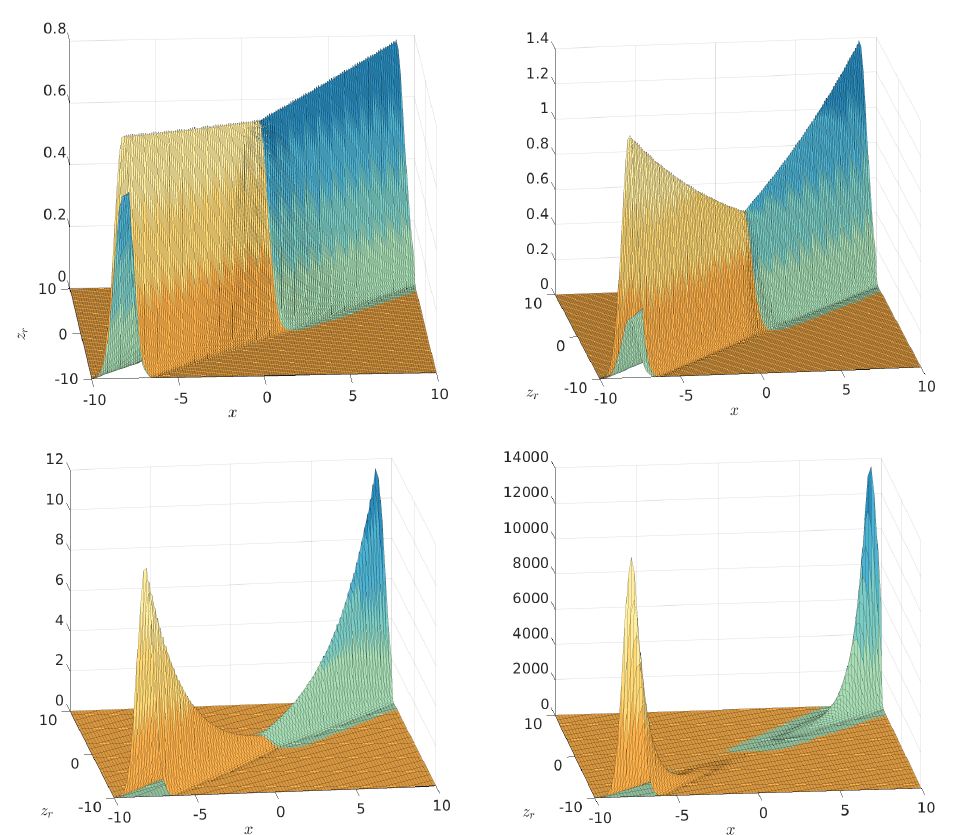
Figure 1. | ψ ( z ; x ) | 2 (orangish) and | ϕ ( z ; x ) | 2 (blueish) in (50) and (51) for different α and β and for λ = 0.1 and ω = 0.5: ( top left ) α = 0.3, β = 0.31; ( top right ) α = 0.3, β = 0.35; ( bottom left ) α = 0.3, β = 0.5; ( bottom right ) α = 0.3, β =